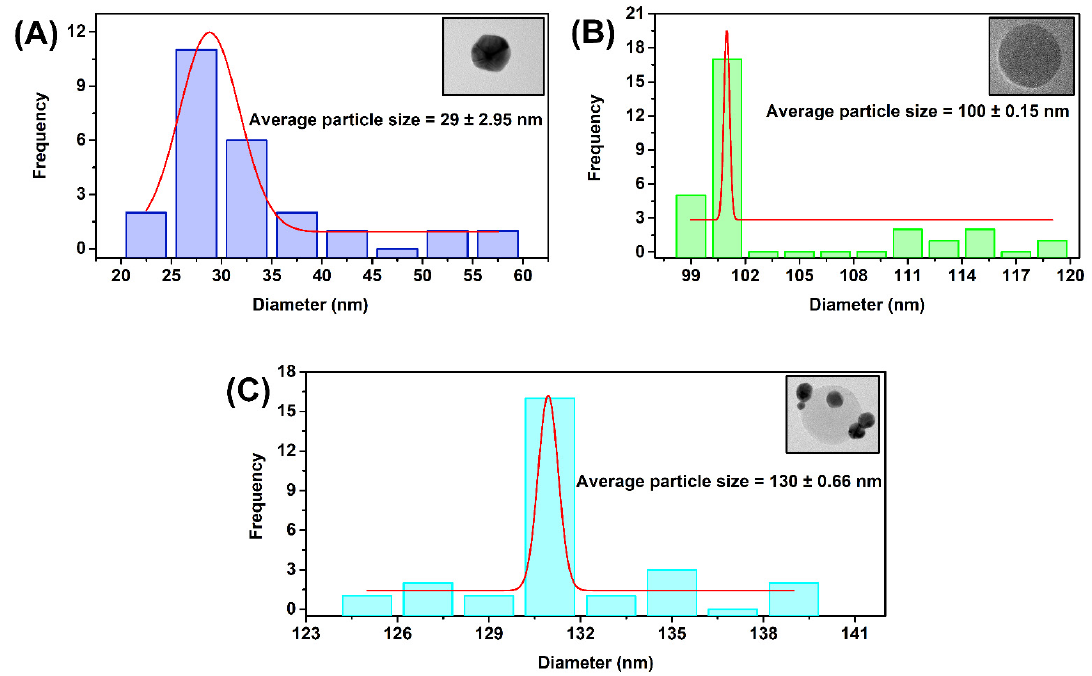
Figure 5. Particle size distribution of ( A ) Cys AuNPs; ( B ) Commercial EuNPs; ( C ) Cys Au-EuNPs. 2.3. Development of a Cys Au-Eu NPs Conjugate Linked RDT and FICT Assay The antibody conjugation of the Cys Au-EuNPs was tested using RDT and FICT as- says, with the images obtained by the naked eye and medisensor analysis, respectively (Figure 6). To achieve this, the RDT and FICT assays and nanoparticles conjugates were loaded onto a conjugation pad and dried for 15 min at 37 °C. A lack of reaction between the conjugated material and the monoclonal antibody (mAb) on the TL (test line) indicates the absence of the virus, whereas a reaction indicates that the virus is present. The CL (control line) strips were coated with anti-mouse IgG, which recognizes the sample virus NP antibody (Ab) in the conjugates. Thus, the LFIA kits were used as the tests. Both the colorimetric and fluorescence signals were noted within 25 min of placing the virus sam- ple onto the strip. The TL/CL values indicate the amount of virus in the sample. A com- parison of the RDT and FICT was achieved, using commercial AuNPs and EuNPs conju- gates as a positive control.